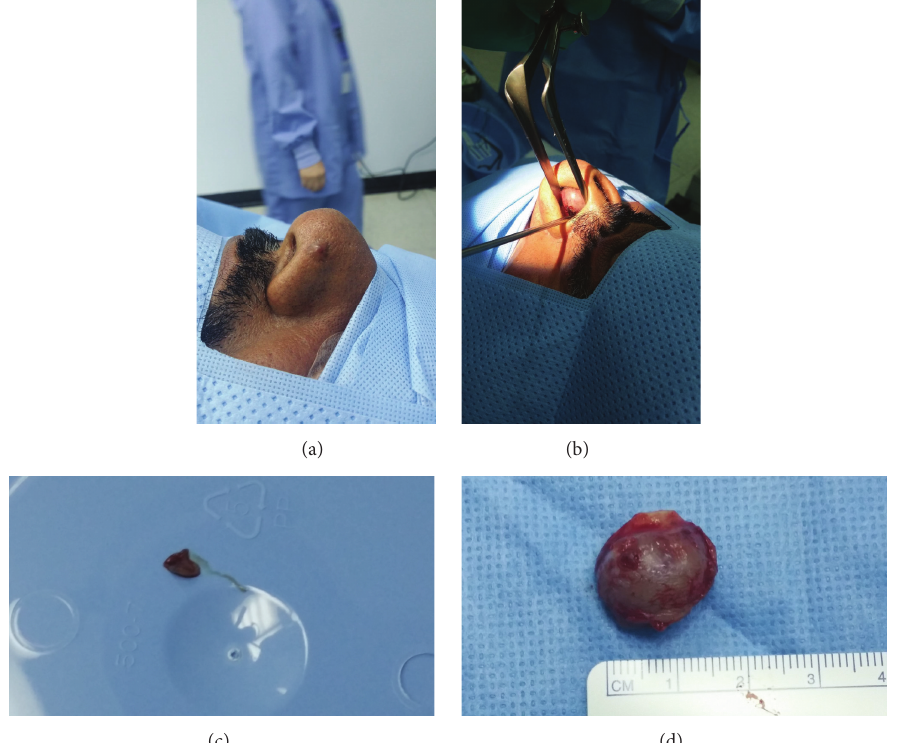
Figure 1: (a): Left sided raised nasal alar lesion. (b) Right sided nasal septal mass. (c) Wide local excision of left sided nasal alar lesion. (d) Excision biopsy specimen of right sided nasal septal